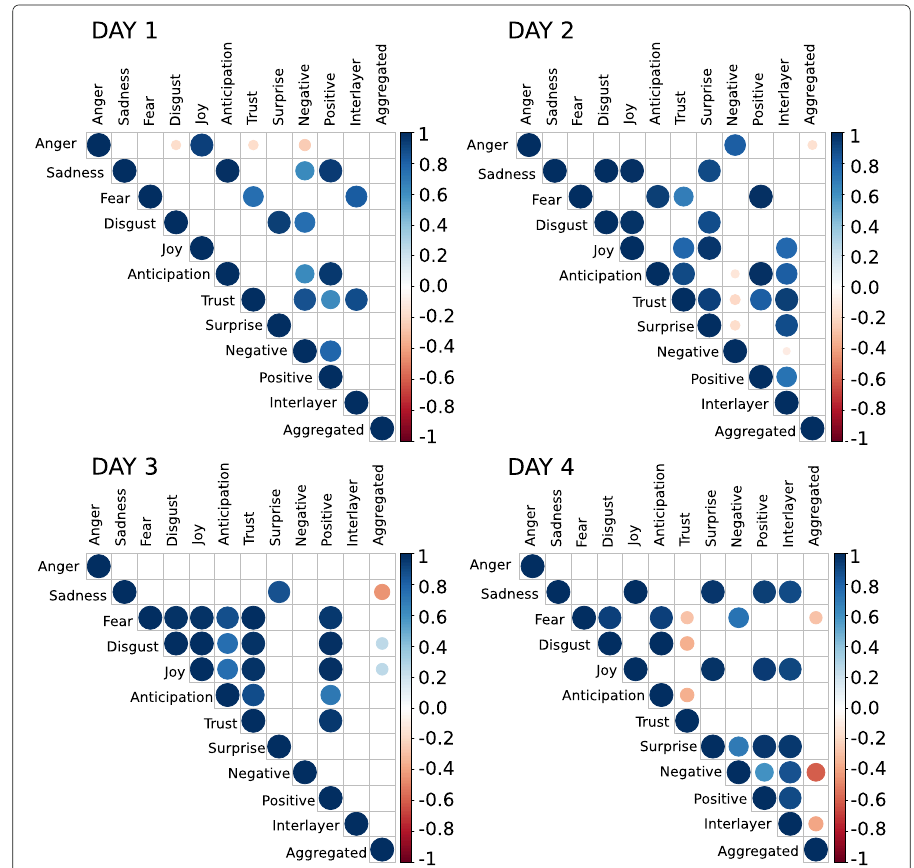
Fig. 11 Pearson correlation coefficient matrix ( p < 0.05) of the daily significance profile (SP) of motif sequences (days 1-4) for each emotion layer of our multiplex network. Only statistically significant values are shown in the